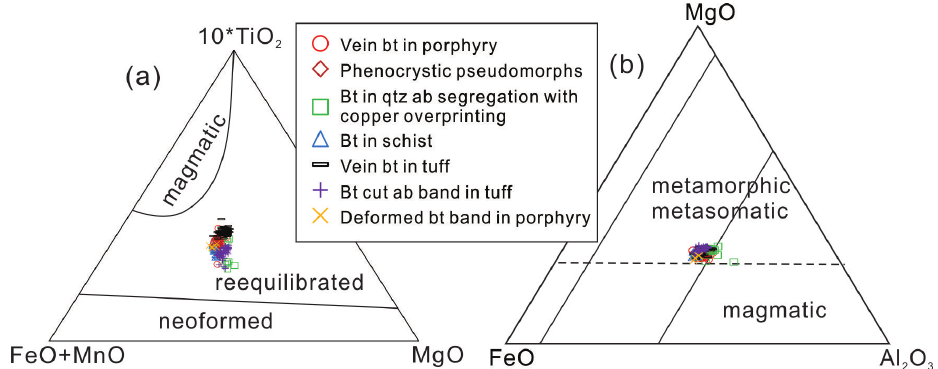
Figure 12. ( a ) A 10 × TiO 2 -FeO + MnO-MgO ternary diagram from Nachit et al. [53]; ( b ) A MgO-FeO-Al 2 O 3 ternary diagram from Gokhale